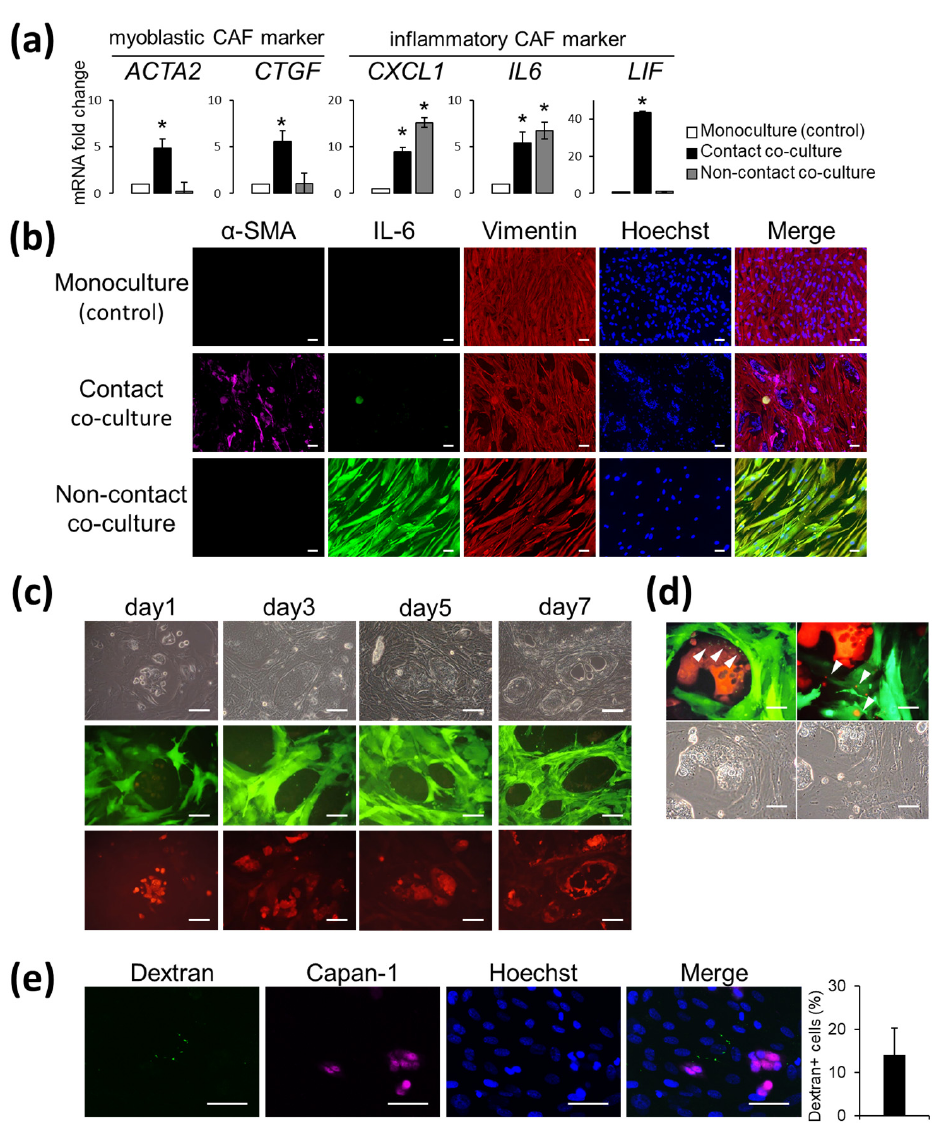
Figure 1. Adipose-derived mesenchymal stem cells (AD-MSCs) differentiated into adipose-derived cancer-associated fibroblasts (AD-CAFs) upon co-culture and interaction with Capan-1 cells: ( a ) qPCR analysis of myoblastic cancer-associated fibroblast (CAF) markers or inflammatory CAF markers in three culture conditions. Results are presented as the mean ± standard deviation of three biological replicates. * p < 0.05, unpaired Student’s t -test; ( b ) Representative immunofluorescent image of AD-MSCs co-cultured with/without Capan-1 cells and stained for α SMA (magenta), IL-6 (green), and vimentin (red). Counterstain: Hoechst 33342 (blue). Scale bar: 100 µ m; ( c ) Representative image of direct contact co-culture of green fluorescent protein (GFP)-tagged CAFs with red fluorescent protein (RFP)-tagged Capan-1 cells on days 1, 3, 5, and 7. Scale bar: 100 µ m; ( d ) Magnified images of direct contact co-culture of GFP-tagged CAFs with RFP-tagged Capan-1 cells on day 7. Arrowheads indicate vesicles formed by interaction of AD-MSCs with Capan-1 cells. Scale bar: 50 µ m; ( e ) Representative fluorescent image confirming macropinocytosis in the co-culture of AD-MSCs and Capan-1 cells (magenta) after the addition of FITC-dextran and quantification of dextran uptake by cells. Counterstain: Hoechst 33342 (blue). Scale bar: 50 μ m.